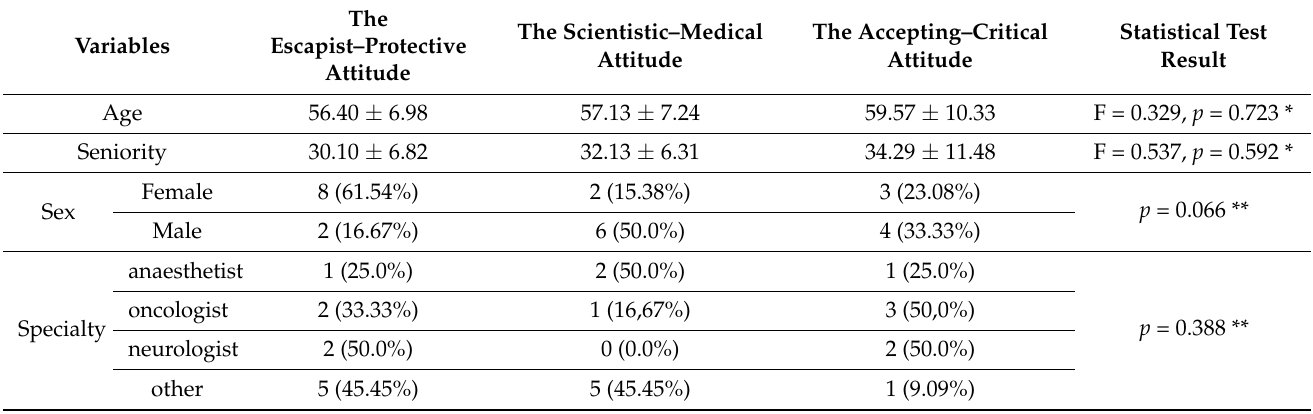
Table 3. Attitudes of the interviewees towards brain death depending on age, seniority, sex and specialty.